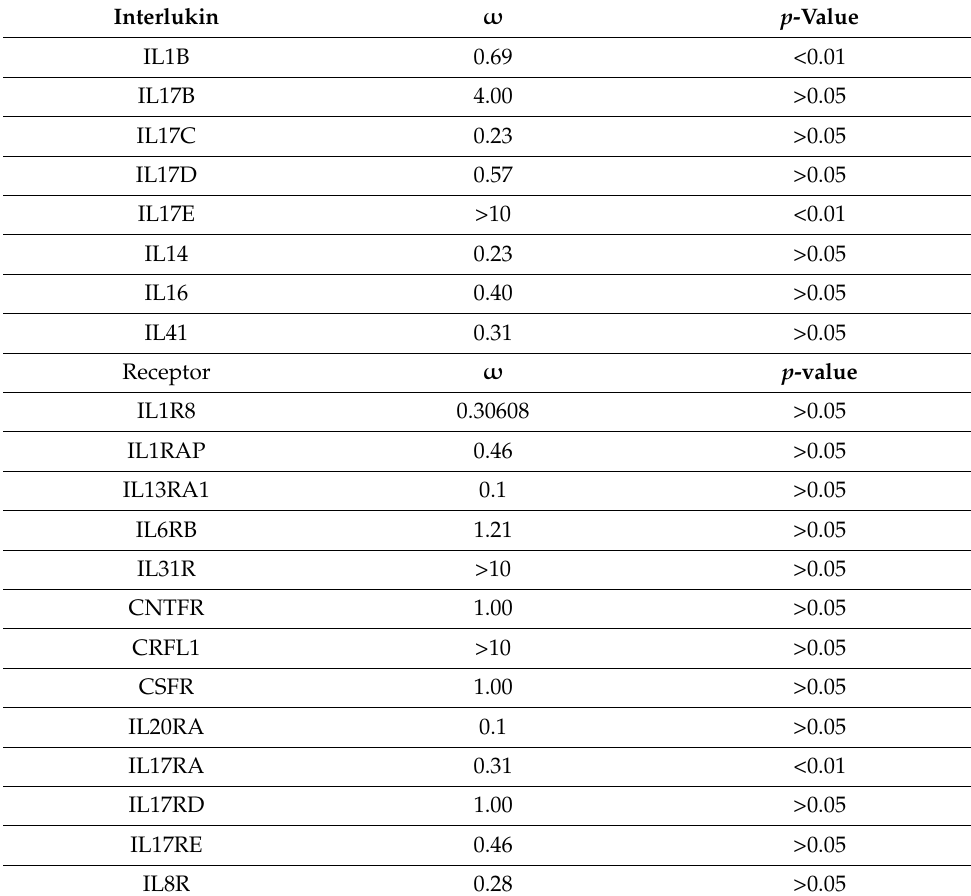
Table 3. Positive selection test for ILs and ILs receptors expressed in